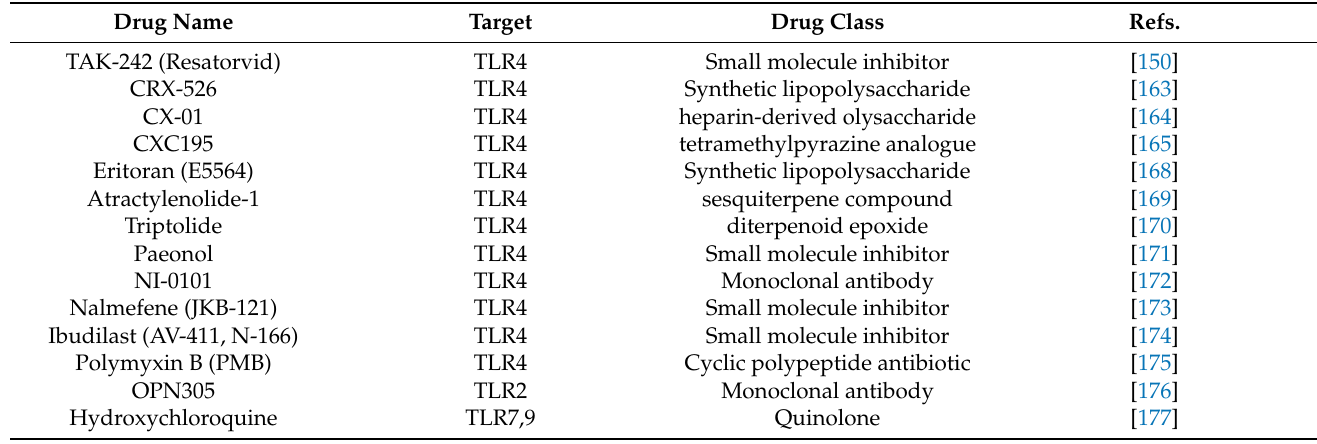
Table 4. List of antagonists of